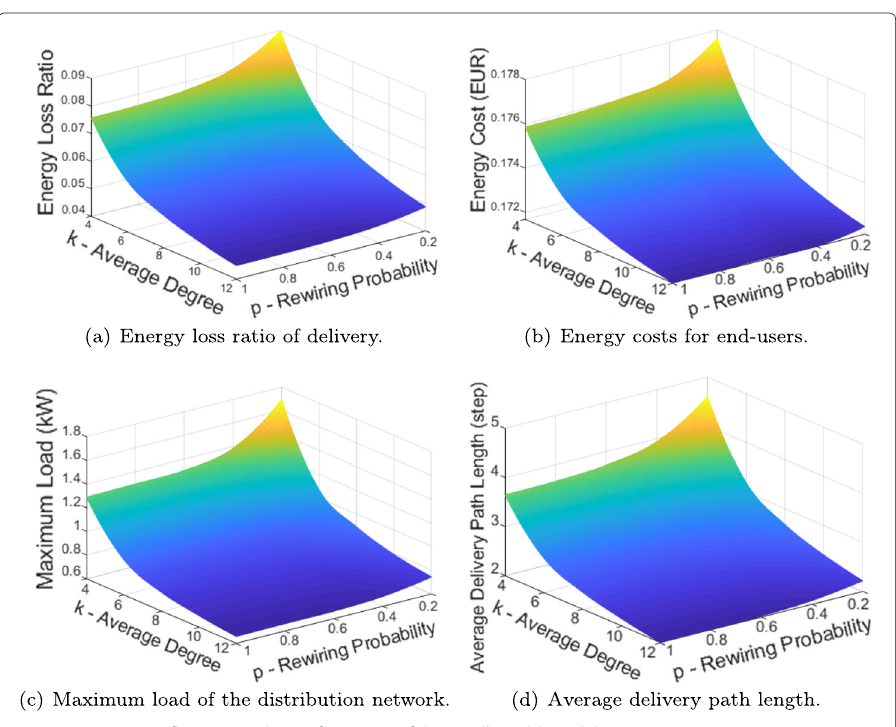
Fig. 8 Parameter influence on the performance of the small-world model